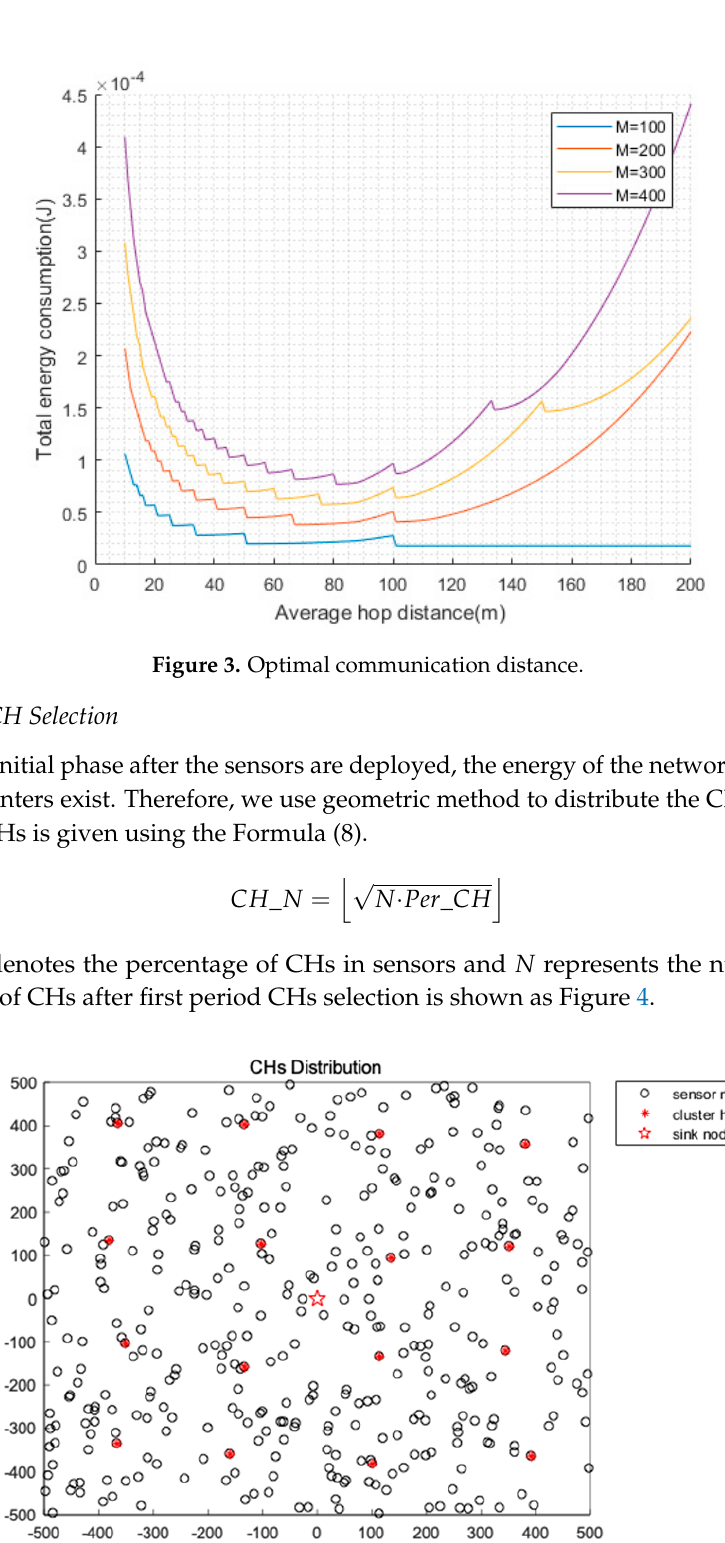
Figure 3. Optimal communication distance.